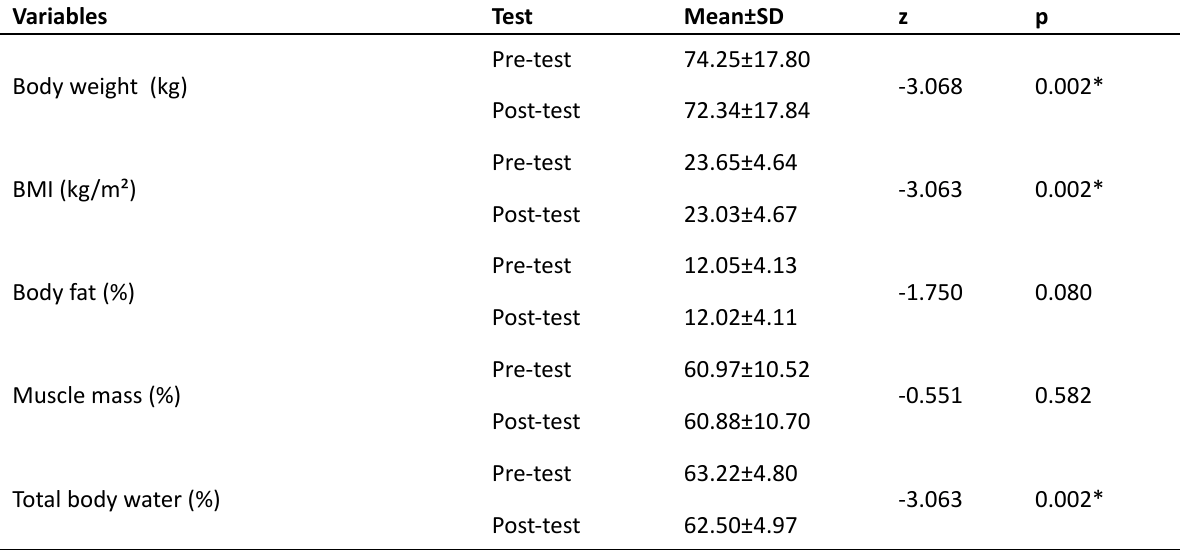
Table 3. Comparison of the physical and physiological characteristics of the athletes participating in the research